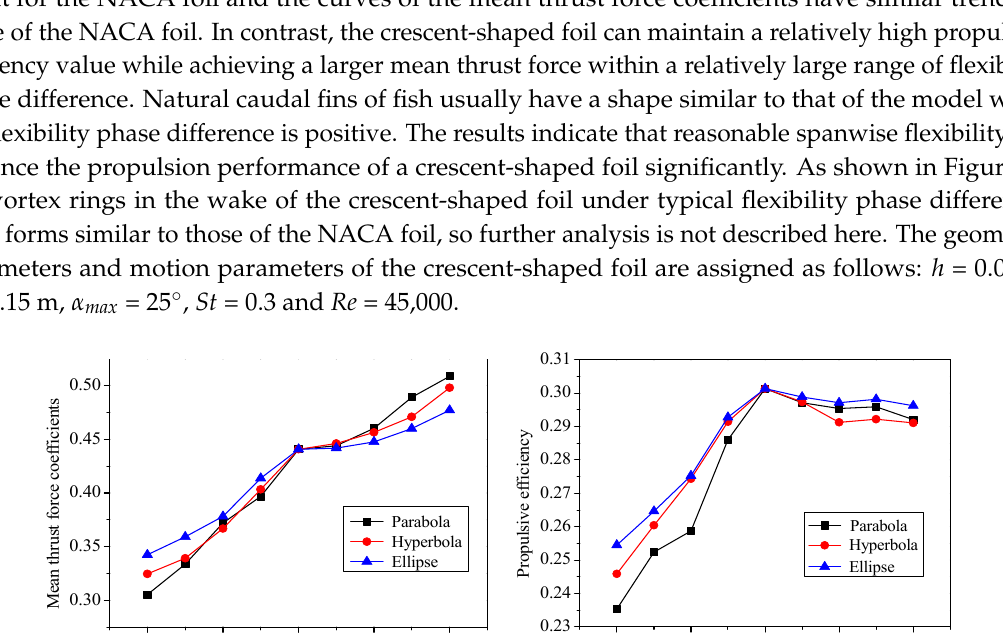
Figure 14. Performance curves versus phase difference of the crescent-shaped foil: ( a ) mean thrust force coefficients; ( b ) propulsive efficiency.